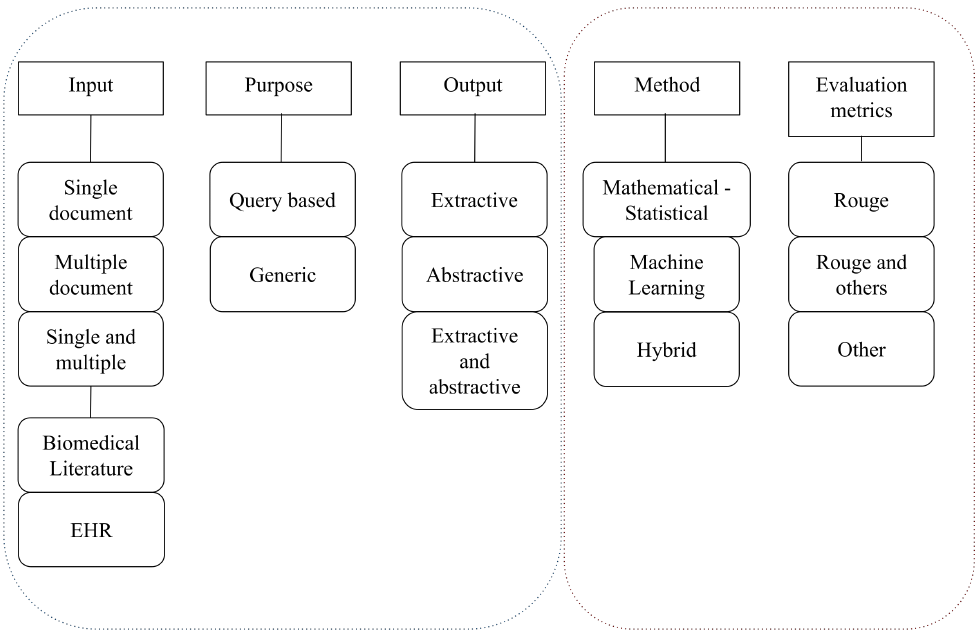
Figure 2. Classification of summarization